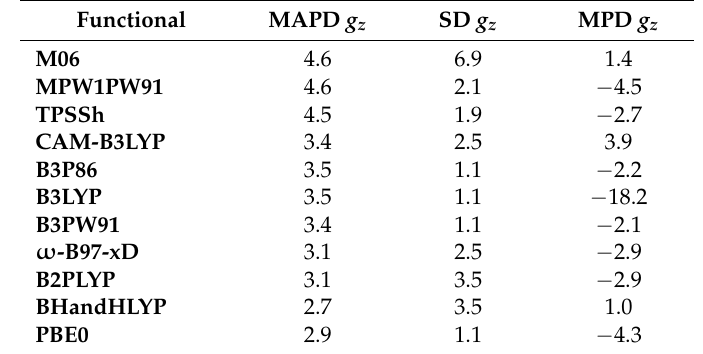
Table 3. Mean absolute percent deviation (MAPD) and mean percent deviation (MPD) from the experimental value g z of the fourteen Cu(II) complexes, and standard deviation (SD) as a function of the functional 1